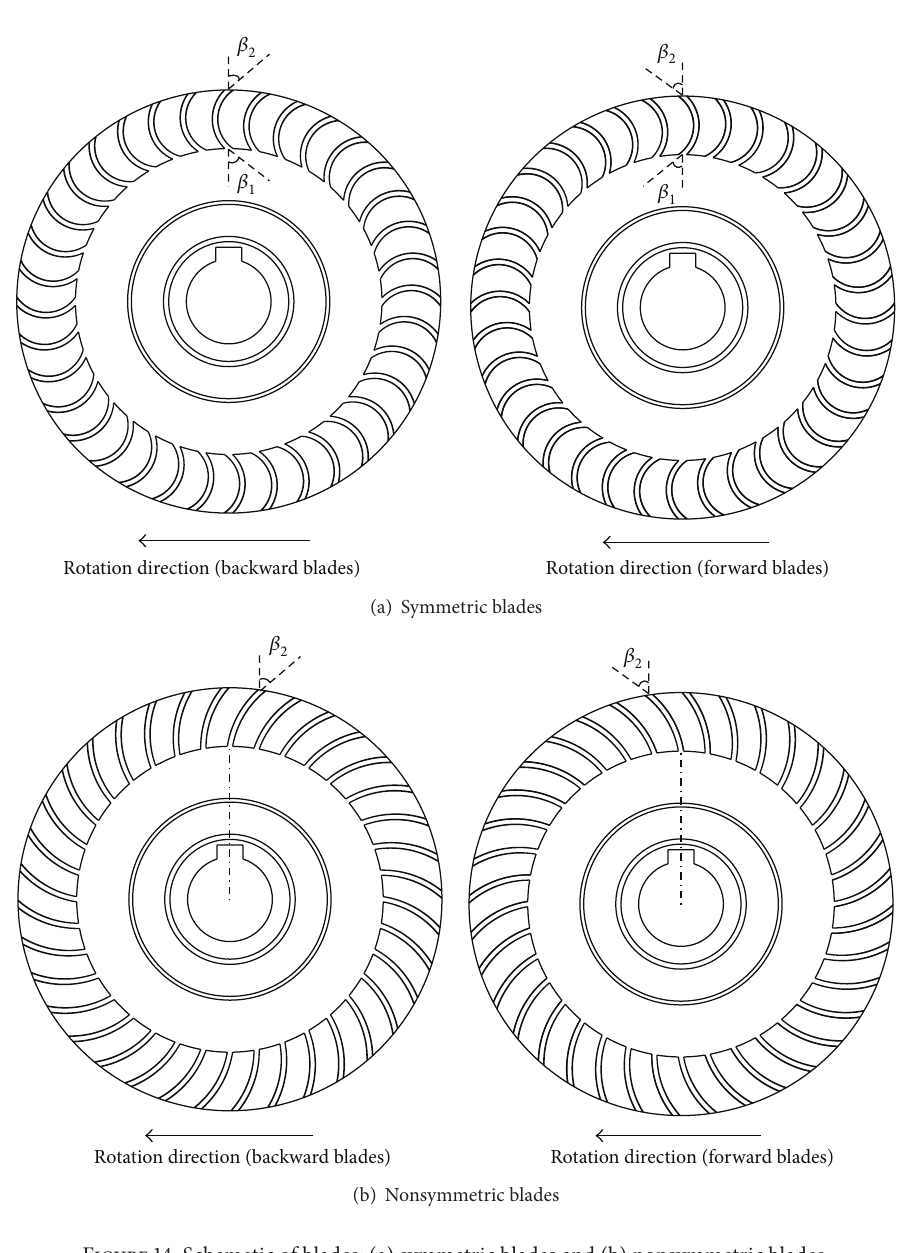
coefficients are increased at blades angle of +10 ∘ and +30 ∘ and reduced at angle of +50 ∘ relative to radial blades. Both cases (backward/forward) of nonsymmetric angle blades have not better performance than radial blades